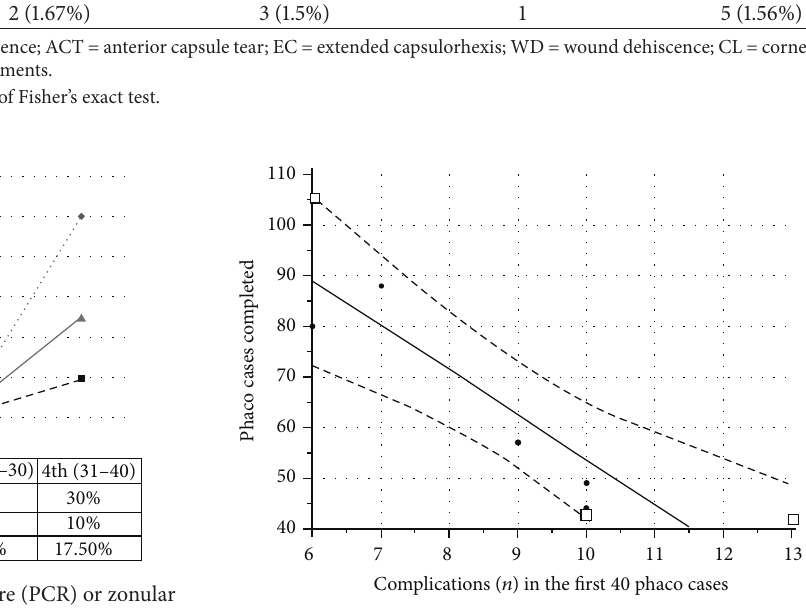
Figure 2: Scatter diagram and regression line (continuous line) showing correlation between the number of complications each resident had in their first 40 phaco cases and the total number of proceduresthattheywereallowedtoperform.Thetwodottedcurves drawn parallel to the regression line represent a 95% confidence interval for the regression line. The residents of Group A are marked with white squares, whilst those of Group B are marked with black